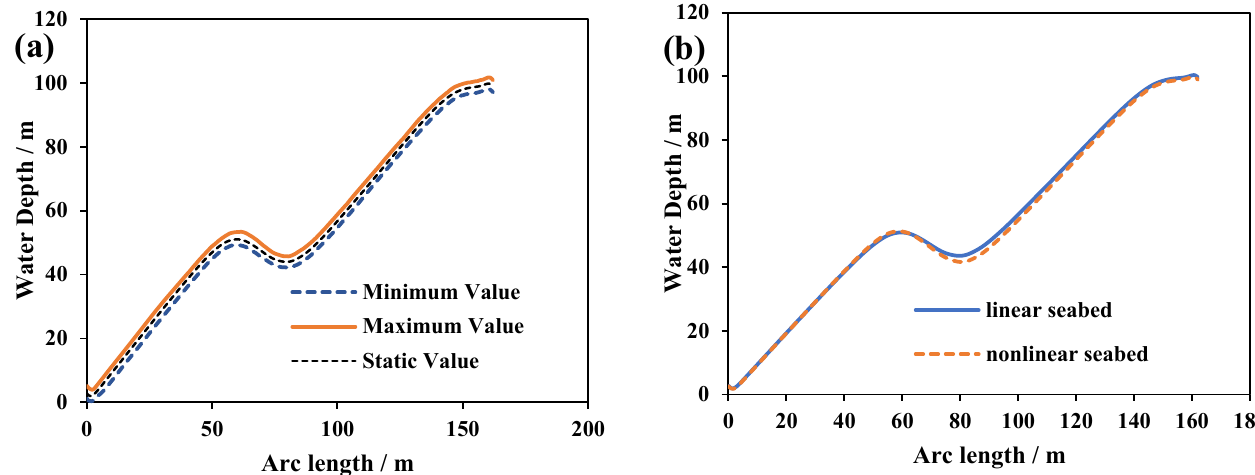
Figure 34. Influence of water depth and hose static offset in Lazy-S configuration on submarine hoses. ( a ) Effect of water depth on static offset configuration of lazy-S hoses for linear seabed. ( b ) Effect of water depth on static offset for linear and non-linear seabeds.